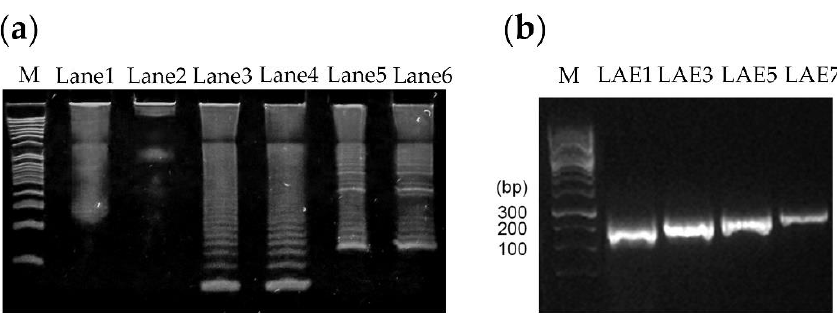
Figure 2. ( a ) PAGE analysis of the products generated using two di ff erent concentrations of oligonucleotide sets in the first (Lanes 1–2) and second rounds (Lanes 3–4) of TR-PCR, and adapter PCR (Lanes 5–6). Lanes 1 and 2: first round TR-PCR products using 100 pM and 10 µ M of oligonucleotides, respectively. Lanes 3 and 4: corresponding products from the second round of TR-PCR. Lanes 5 and 6: corresponding products from the adapter PCR.; ( b ) PCR amplification of the LAE1, LAE3, LAE5 and LAE7 expression cassettes from the respective pLAE1, pLAE3, pLAE5 and pLAE7 pGEMT-Easy vectors showing product target sequences of 115 bp, 169 bp, 223 bp and 277 bp, respectively. PADRE primers were used for the PCR reactions.